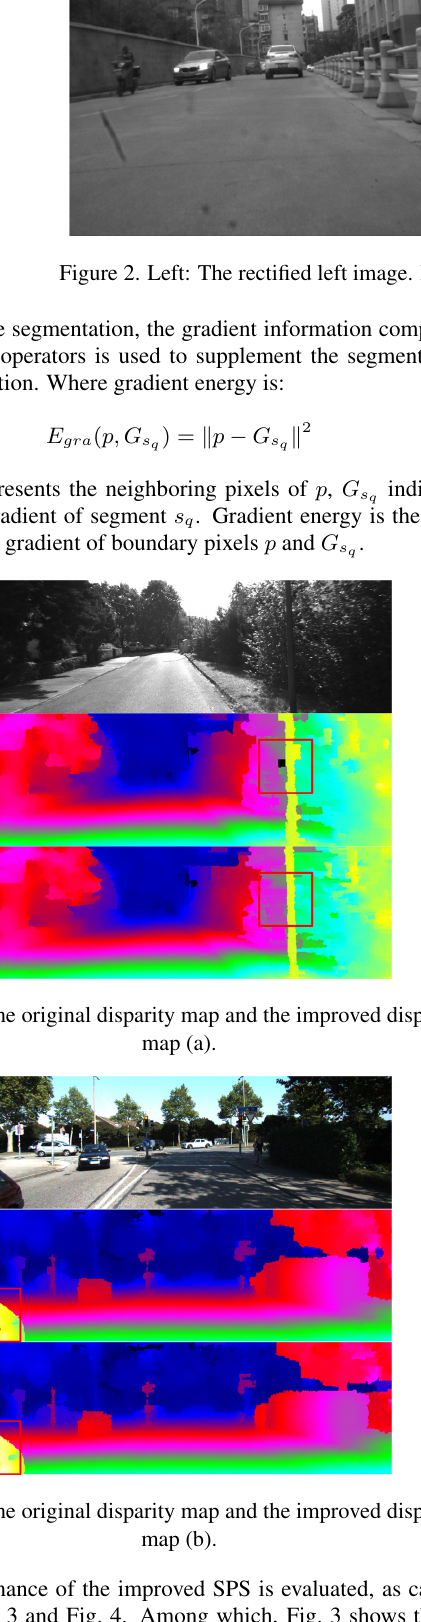
Figure 4. The original disparity map and the improved disparity map (b).